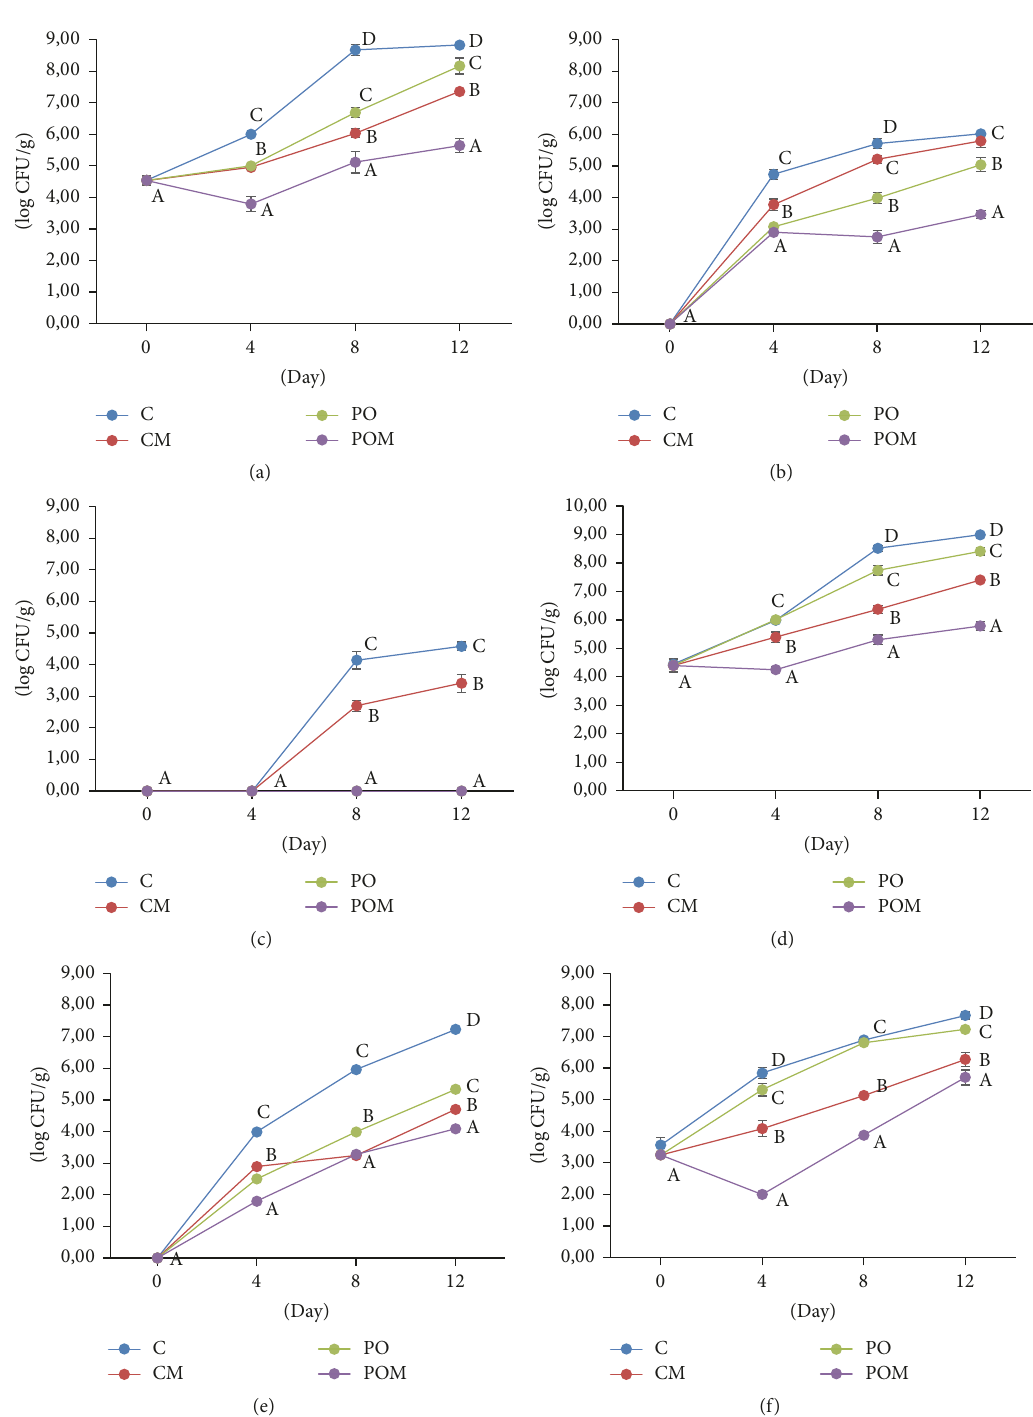
Figure 5: Evolution of the natural microbiota of WPI-Or coated hake fillet stored under air and MAP conditions. C: control, CP: control-WPI, PO-1: WPI + Or 1%, PO-3: WPI-Or 3% ( 𝑝 < 0.05 ). (a) Total viable counts; (b) lactic acid bacteria; (c) Enterobacteriaceae ; (d) psychrotrophic bacteria; (e) H 2 S- producing bacteria; (f)